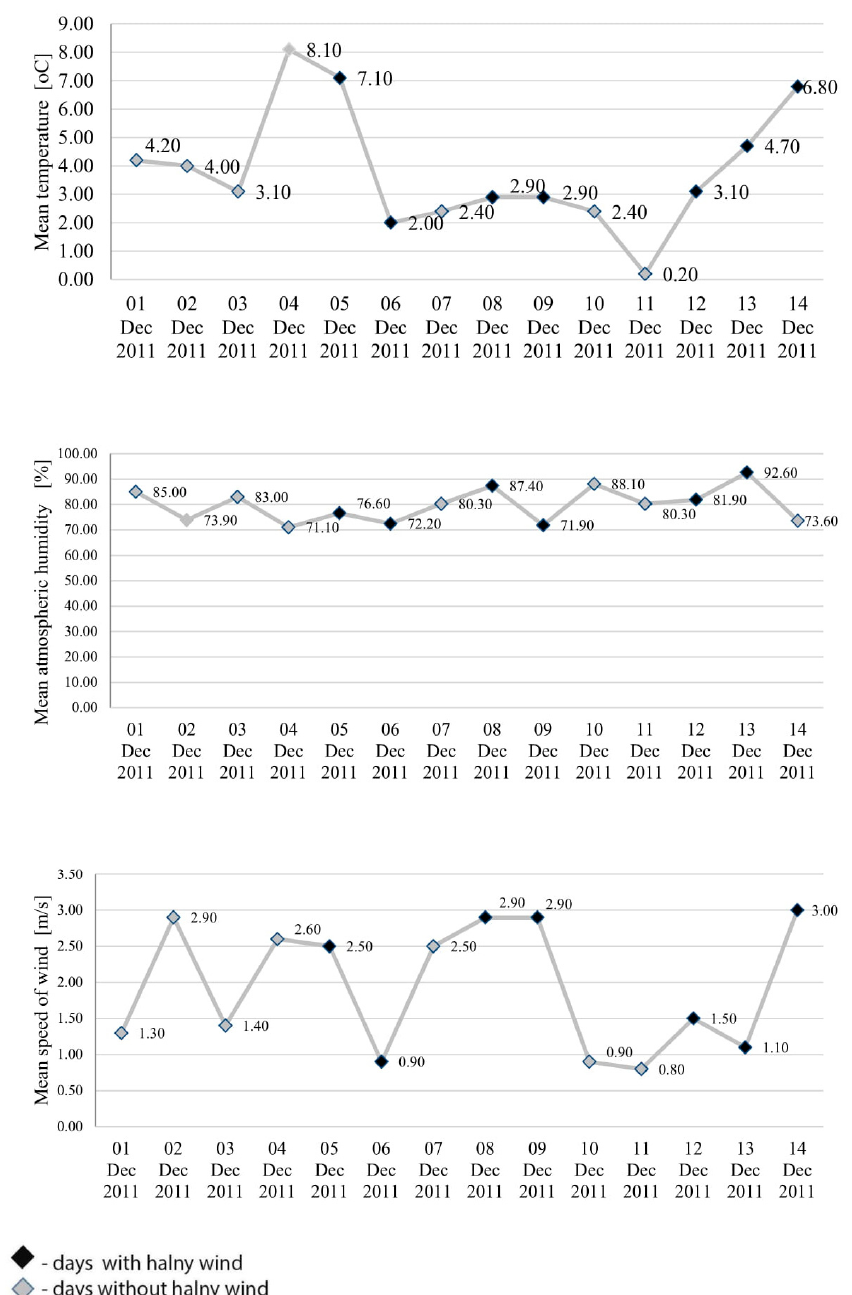
Figure 1. Changes in mean daily air temperature, atmospheric humidity and speed of wind for the period from 1 to 14 December 2011.